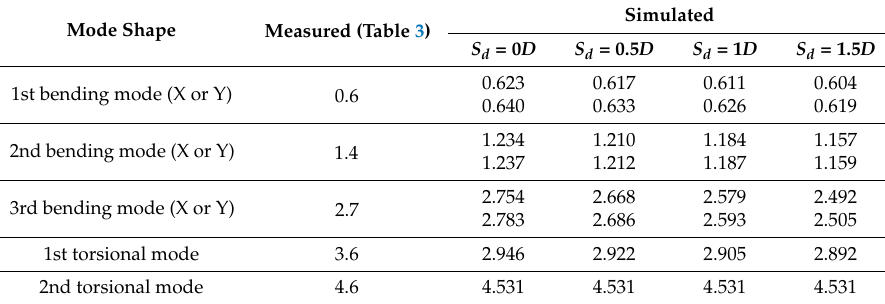
Table 9. Natural frequencies of met mast structure—case